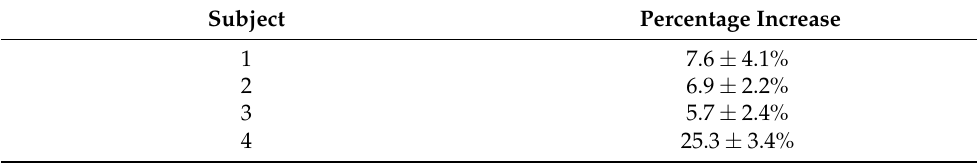
Figure 5. Distributions of vPWV values measured pre-, during, and post-PLR, distinctly presented for the 4 subjects by means of boxplots. The line inside of each box represents the median, while the top and bottom edges are the upper and lower quartiles, respectively. Whiskers extend over the whole data range, except for the data beyond 1.5 times the interquartile range (IRQ) above the upper quartile or below the lower quartile, which are individually plotted as circles. No data were excluded as outliers, i.e., beyond 3SD from the mean. There was consistent increase in vPWV during PLR. Differences between distributions were assessed via t-tests, adjusting resulting p-values for multiple comparisons by means of Bonferroni correction (*: p < 0.05; **: p < 0.01). Table 1. Percentage increases in vPWV during PLR with respect to baseline for each